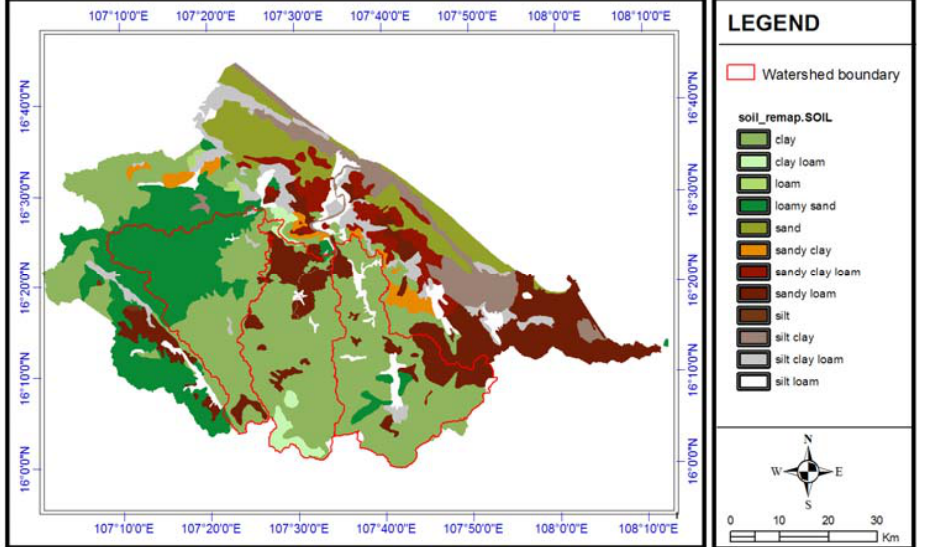
Figure 3. Soil types map of Thua Thien Hue province showing 12 soil type classes. The major soil types are major soil types are clay (37.3%), loamy sand (17.6%), and sandy loam (15.5%).